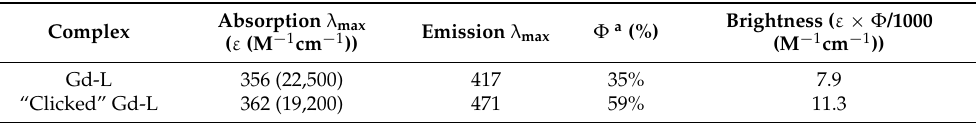
Table 1. Photo-physical data for Gd(III) complexes measured in 100 mM HEPES, pH 7.4 (298 K).